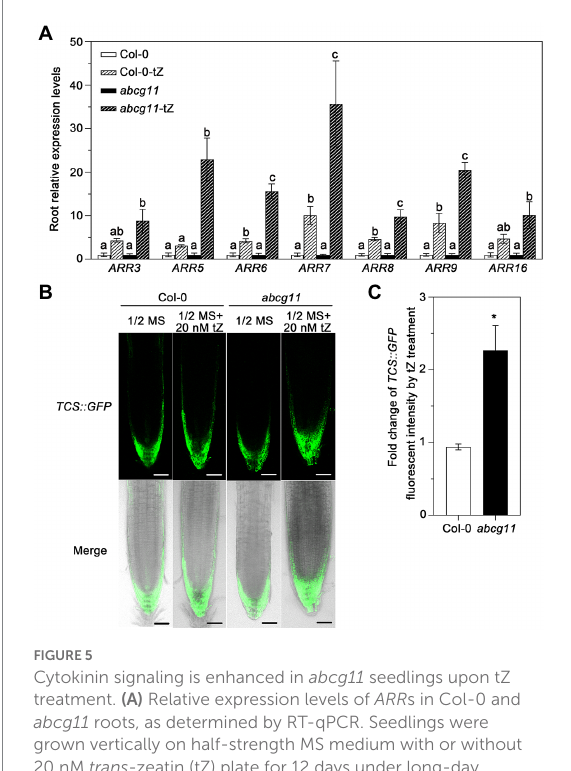
FIGURE 5 Cytokinin signaling is enhanced in abcg11 seedlings upon tZ treatment. (A) Relative expression levels of ARR s in Col-0 and abcg11 roots, as determined by RT-qPCR. Seedlings were grown vertically on half-strength MS medium with or without 20 nM trans -zeatin (tZ) plate for 12 days under long-day conditions (16 h light/8 h dark). TUBULIN8 served as an internal control; values in Col-0 and abcg11 under control conditions were set to 1. Data are shown as means ± SE ( n = 4). The different letters indicate the significant difference in each gene expression levels determined by one-way ANOVA ( p < 0.05). (B) Fluorescence intensity of TCS :: GFP in the roots of Col-0 and abcg11 . Scale bars, 50 mm. (C) Fold-change in TCS :: GFP fluorescence intensity induced by tZ treatment in the root tips of WT or abcg11 transgenic seedlings expressing TCS :: GFP . Fluorescence intensity was determined using ImageJ. Data are shown as means ± SE from two independent experiments (total 10 biological replicates). Asterisks represent significant differences by Student’s t -test: * p < 0.05.